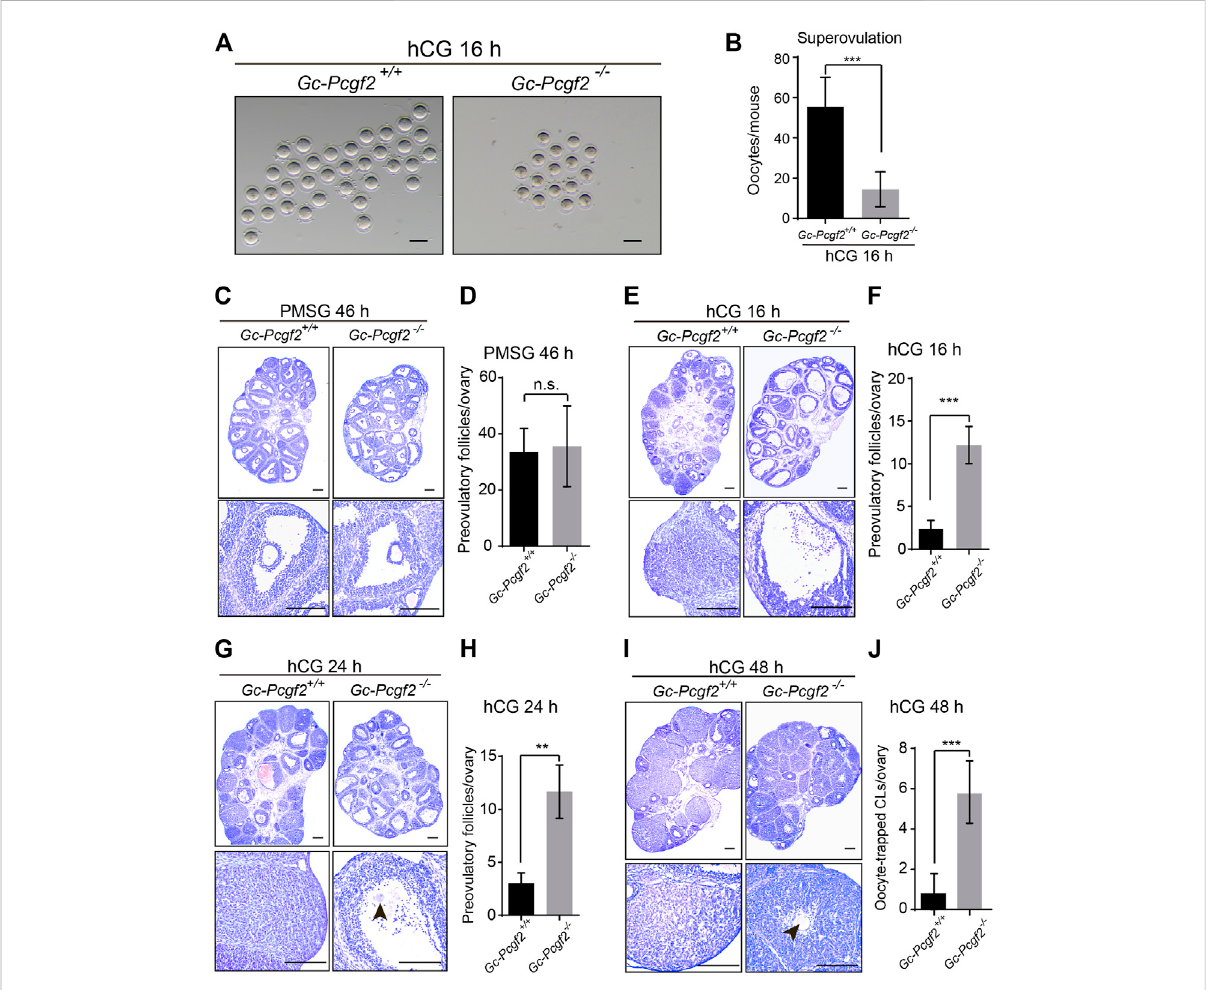
FIGURE 3 Abnormal response to hCG in granulosa cells of GC-Pcgf2 − / − female mice. (A) Images showing ovulated oocytes from GC-Pcgf2 +/+ and GC- Pcgf2 − / − female mice after superovulation. Scale bars: 100 µm. (B) Quantitative analysis results showing a decreased number of oocytes ovulated in GC-Pcgf2 − / − female mice (16 ± 8) compared with in the controls (55 ± 14; n = 9 per group). (C) Histological analysis showing normal